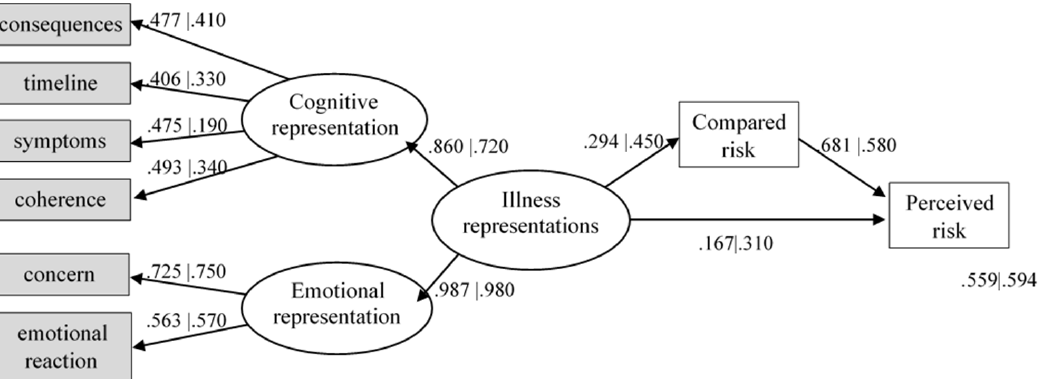
Figure 2. Illness perceptions and compared risk as predictors of individual risk perception for BC. Note. Coefficients on the left are from UAE | Coefficients on the right are from Portugal.